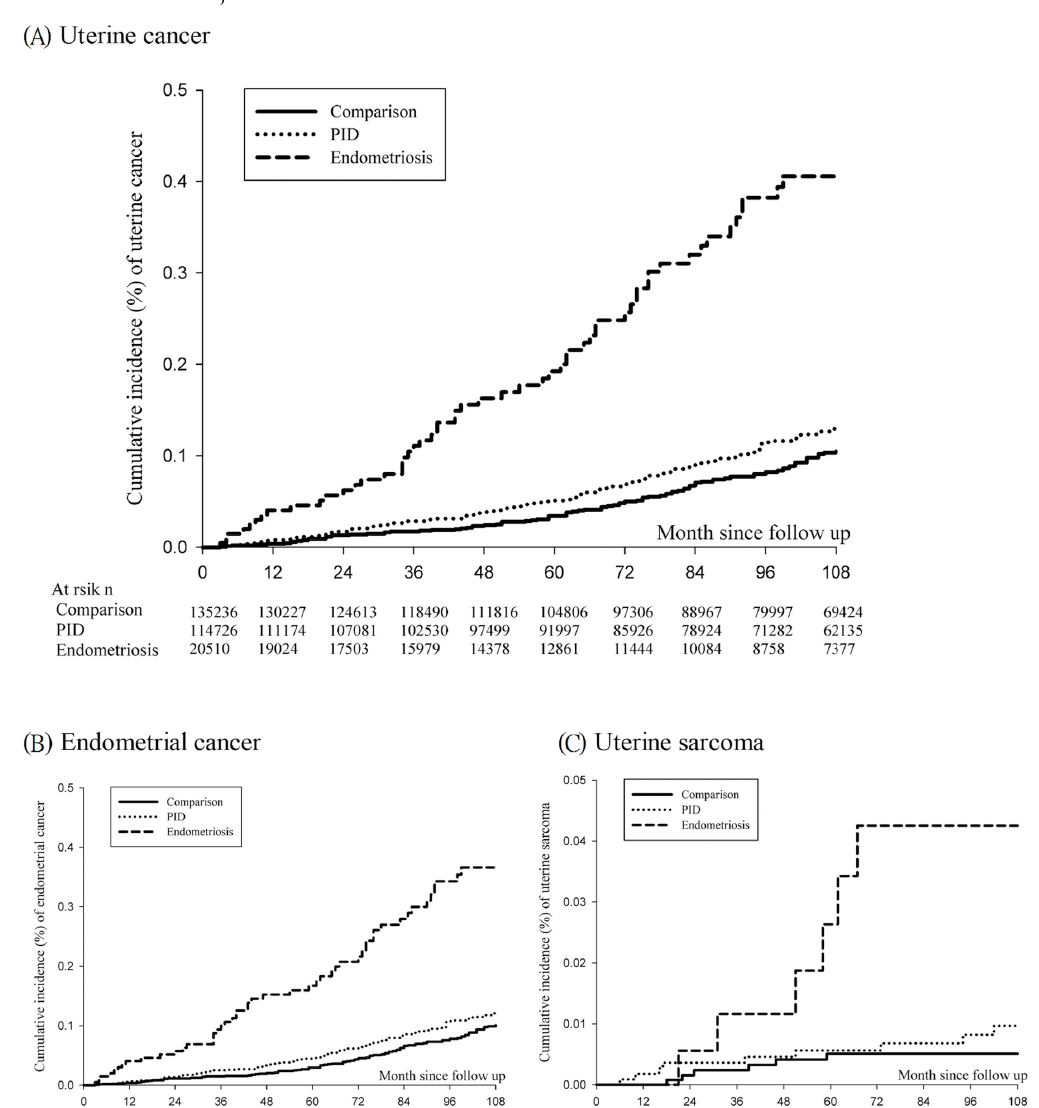
Figure 1. The cumulative incidence of uterine corpus cancer among endometriosis and pelvic in- flammatory and comparison cohorts. ( A ) uterine cancer (log-rank p < 0.001); ( B ) endometrial cancer (log-rank p < 0.001); ( C ) uterine sarcoma (log-rank p < 0.001). PID, pelvic inflammatory disease.